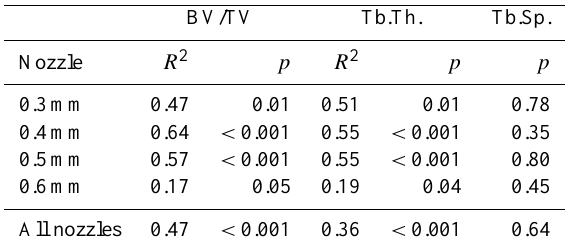
Figure 3. Drilled holes in porcine femora using water jets with var- ious nozzle diameters. Table 2. Statistical outcomes of the experiment of the VRR by dif- ferent nozzle diameters. R 2 : coefficient of determination. p : signif- icance of the regression